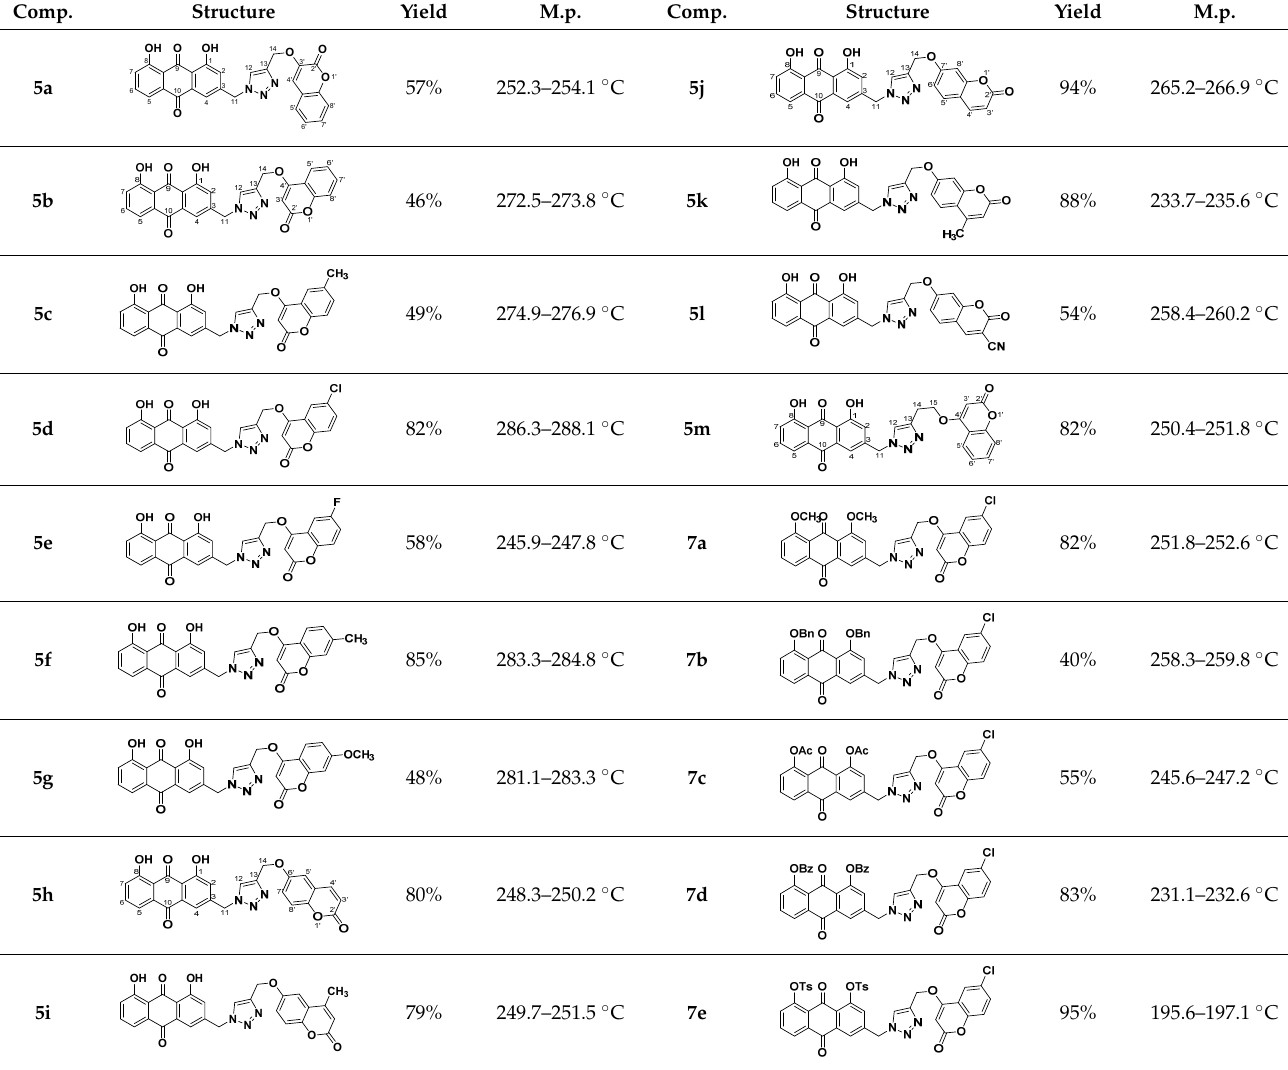
Table 1. The structures, yields and melting points of target compounds 5a – m and 7a – e . Comp. Structure Yield